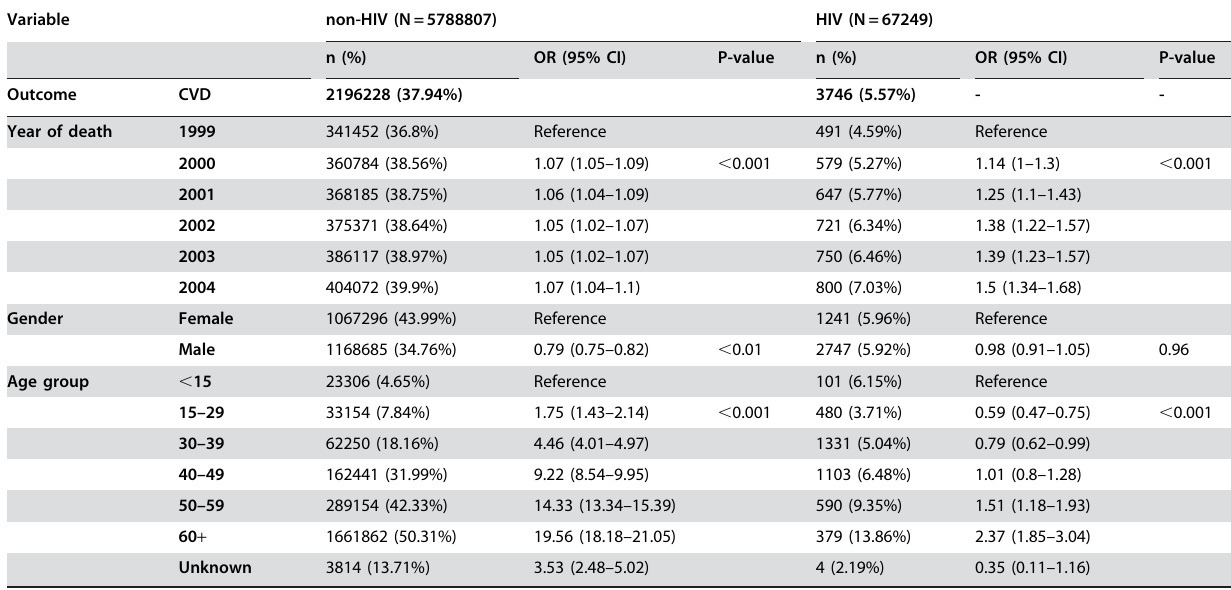
Table 2. Description and odds ratios of having CVD* in any field of the death certificate stratified by reported HIV status** .. ... .... ... ... .... ... ... .... ... ... .... ... ... .... ... ... .... ... ... .... ... ... .... ... ... .... ... ... .... ... ... .... ... ... .... ... ... .... ... ... .... ... ... .